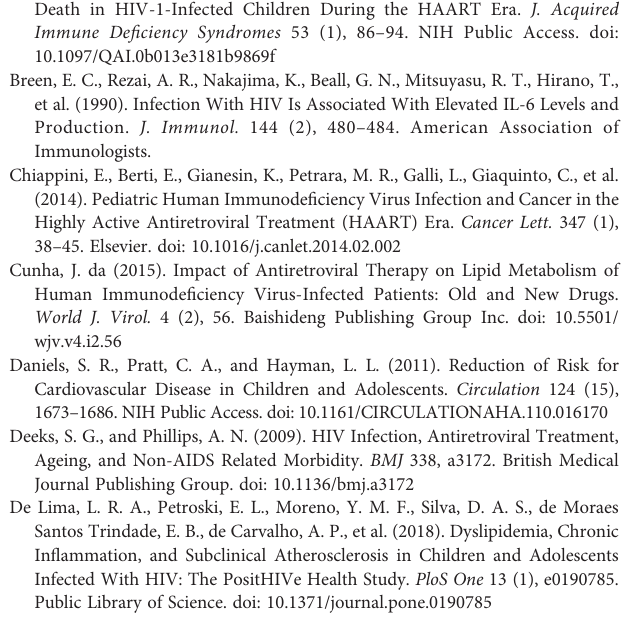
Supplementary Figure 1 | No correlation between ART durationand IL-6 (pg/ml): Each dot representsan ART duration in months and IL-6 concentration pair for each individual volunteer. Statistical analysis was performed using the Spearman rank correlation test. Supplementary Figure 2 | Negative correlation between anti-measles IgG titers and age in HIV+ children: Each dot represents a pair of anti-measles IgG titer and age in years for each individual volunteer. Statistical analysis was performed using the Spearman ’ s rank correlation